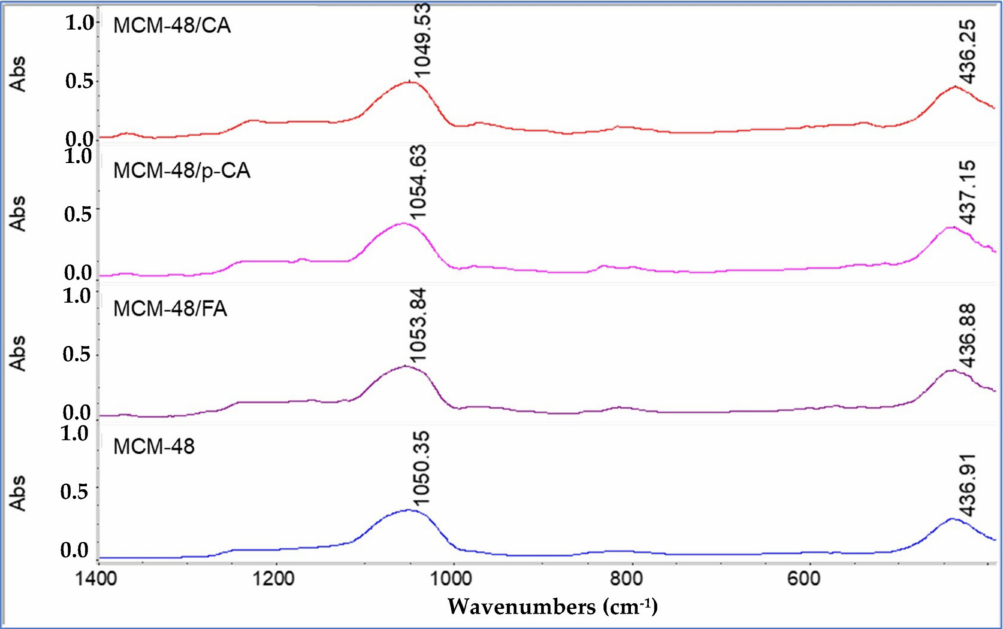
Figure 9. FTIR spectra of samples MCM-48, MCM-48/CA, MCM-48/p-CA and MCM-48/FA (visual- ization on the 400–1400 cm − 1 range).